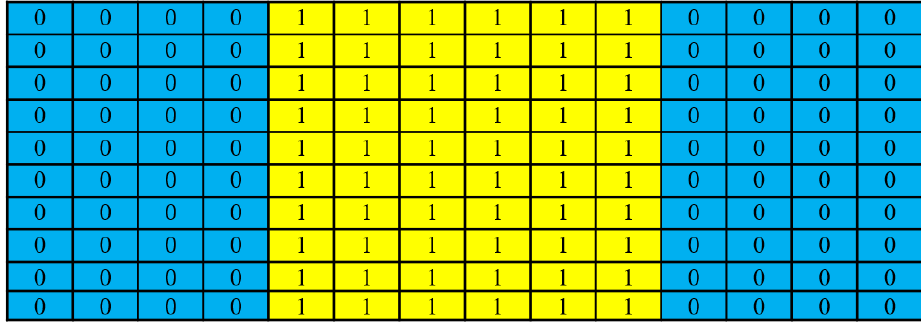
Figure 5. Stepfield designed for the hybrid robot simulation and experimental test.